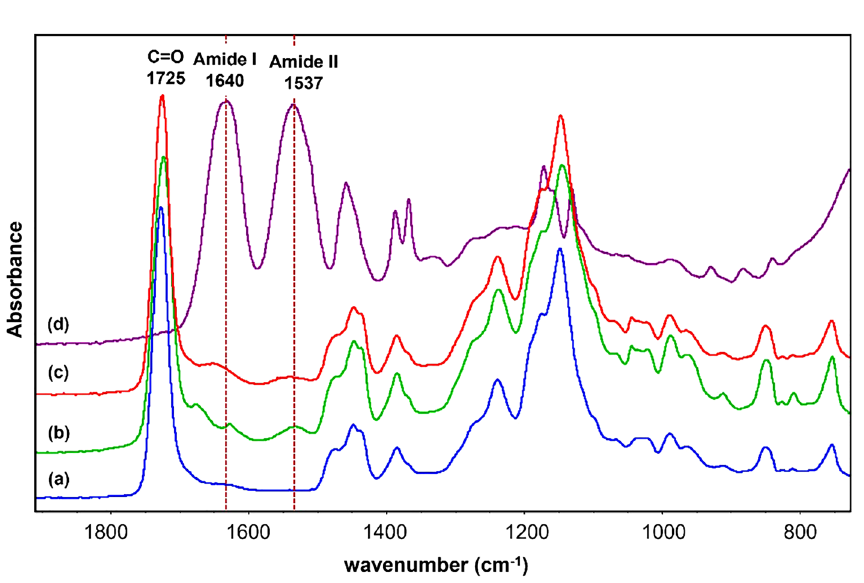
Figure 7. ATR-FTIR spectra of ( a ) neat Eudragit RS100 porous particles, ( b ) PNIPAM@RS100-APS, ( c ) PNIPAM@RS100-APS/TEMED, and ( d ) PNIPAM